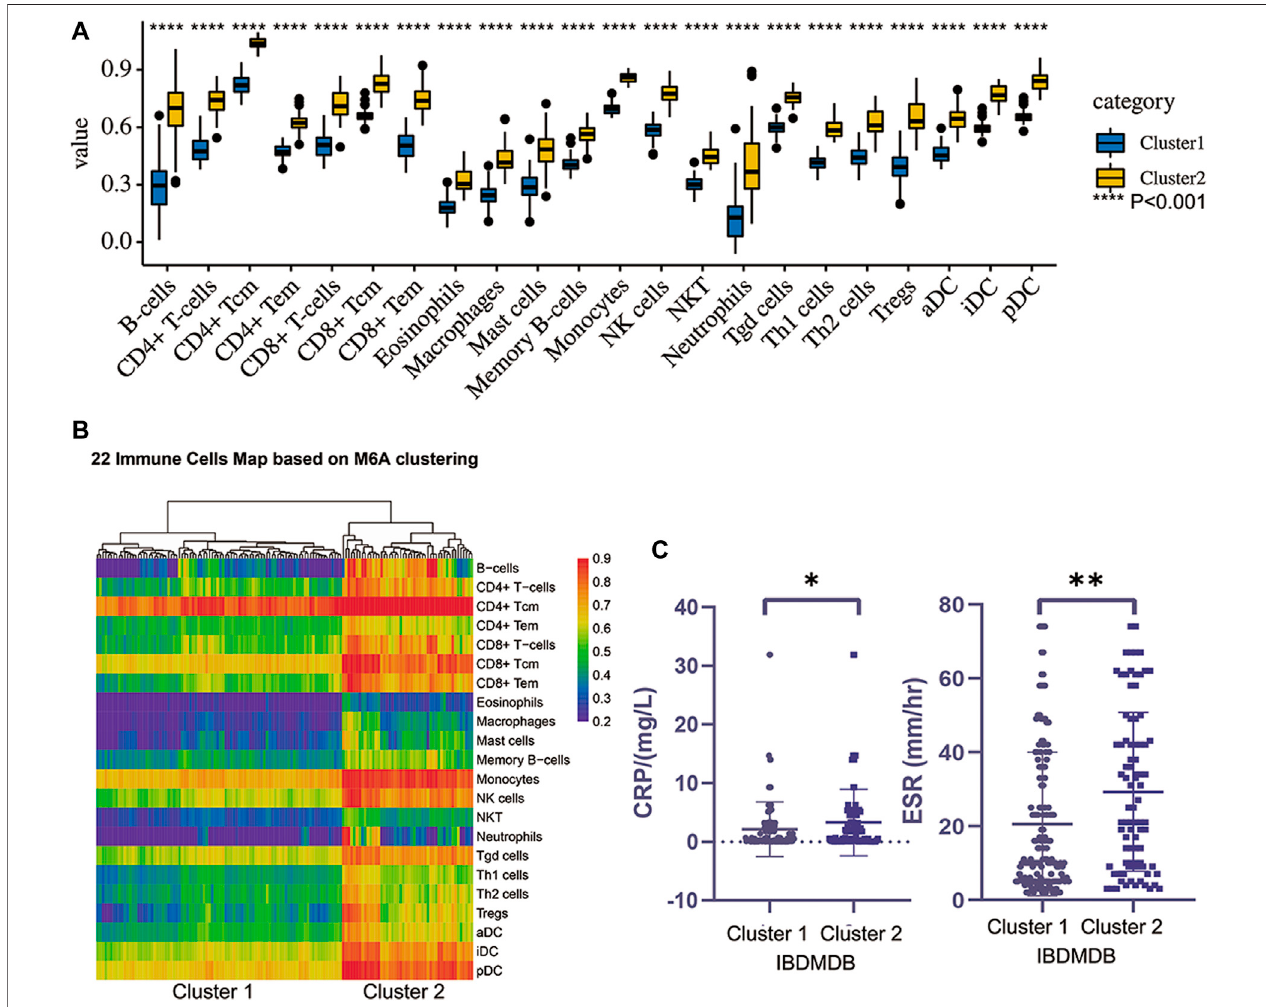
FIGURE4| Thedifferentimmunelandscapeand clinicalphenotypes oftwoclustersobtainedbyconsensus clustering. (A) isthedifferentimmunescoringofmajor 22immunecellsintwoclusters( p < 0.01). (B) istheheatmapofthetwoclusters ’ immunelandscape. (C) isthedifferenceoftwoclustersclinicalindexessuchasESRand CRP (t test, p <